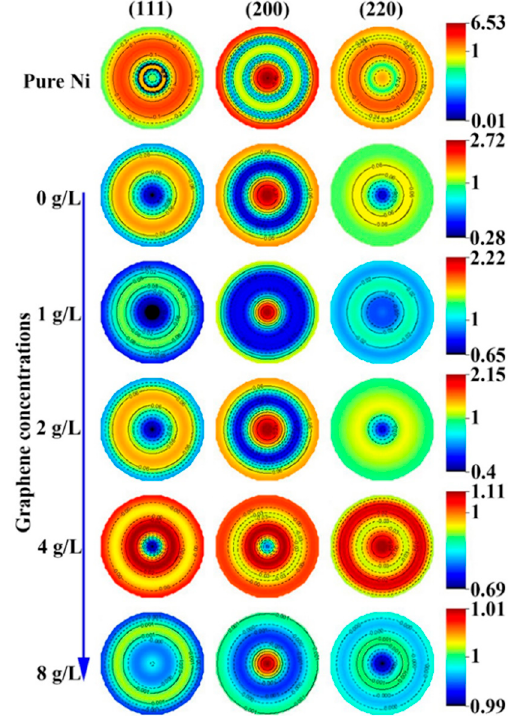
Figure 10. Pole figures of the Ni–Cr–graphene coatings obtained from Rietveld refinements.